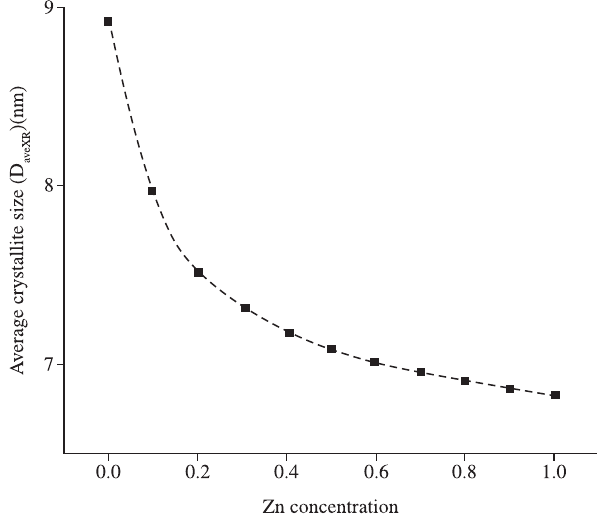
Figure 4. Room temperature magnetization curve of (a) Ni Ni Zn Fe O (c)Ni 0.90 0.10 2 4 (f) i